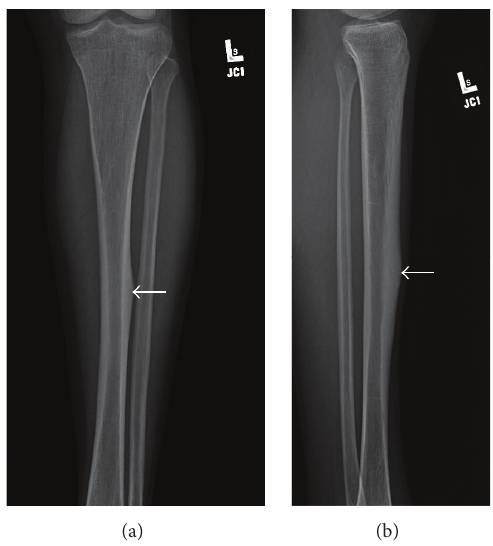
Figure 3: Young adult male with history of Rothmund-Thomson syndrome diagnosed at 2 years of age. Findings: (a) focal thickening of the lateral cortex of the mid left tibia diaphysis (arrow) is visible on AP radiograph obtained at the same time as the 13-month follow-up images of the right tibia fracture. No fracture or underlying lytic bone lesion is apparent. (b) Lateral radiograph of the left tibia shows anterior cortical thickening (arrow). Technique: (a) AP radiograph kVp = 63, mAs = 3, and (b) lateral radiograph kVp = 63, mAs = 3.